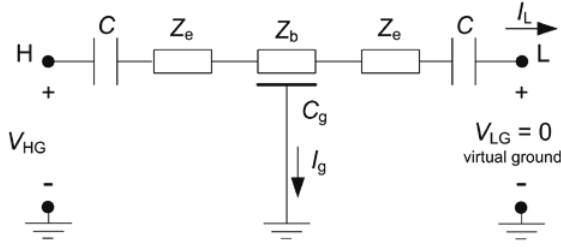
Fig.2: Equivalent circuit when a capacitor C is connected in series with each electrode in bipolar body impedance measurements.